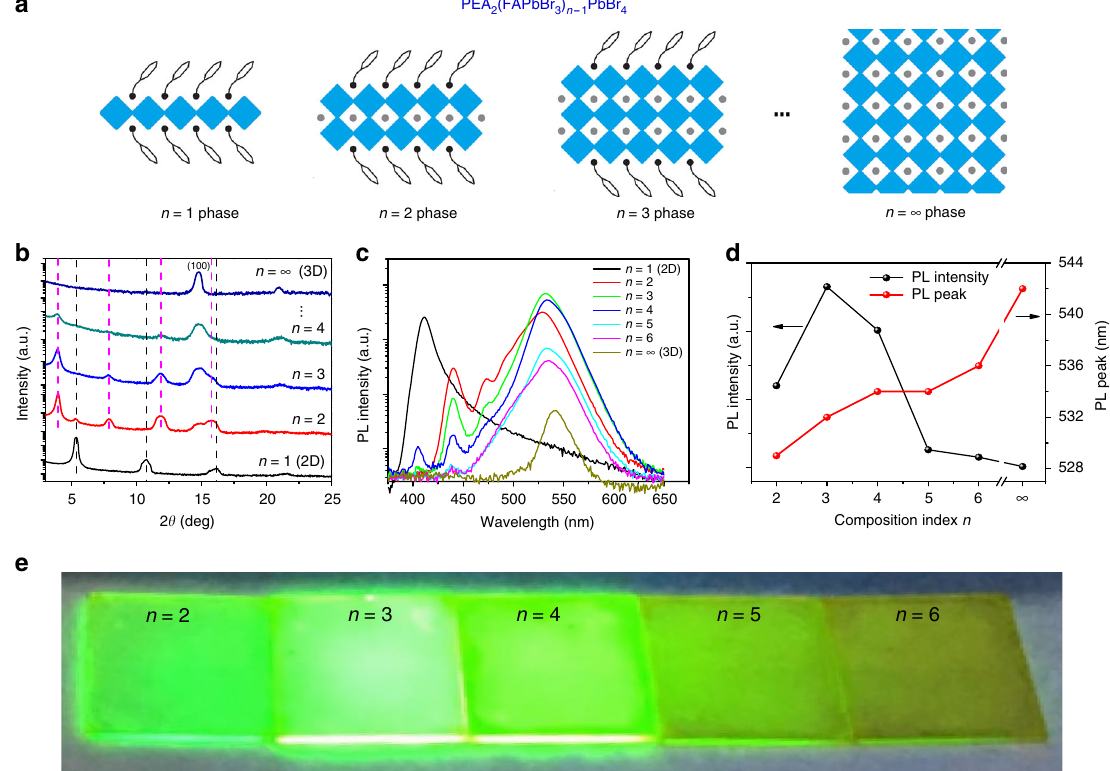
Fig. 1 Properties of perovskite fi lms with different compositions. a Scheme of PEA 2 (FAPbBr 3 ) n -1 PbBr 4 phases. The black part is PEA, the blue square is PbBr 6 -octahedron and the gray dot is FA. b X-ray diffraction patterns of PEA 2 (FAPbBr 3 ) n -1 PbBr 4 fi lms with different n -compositions. Diffraction patterns of n = 1 phase (black vertical lines), n = 2 phase (pink vertical lines) and n = ∞ phase (marked with (100)) were labeled. The analysis details can be found in the Supplementary Table 2. c Photoluminescence of PEA 2 (FAPbBr 3 ) n -1 PbBr 4 with different n -compositions. d Photoluminescence intensity and peak